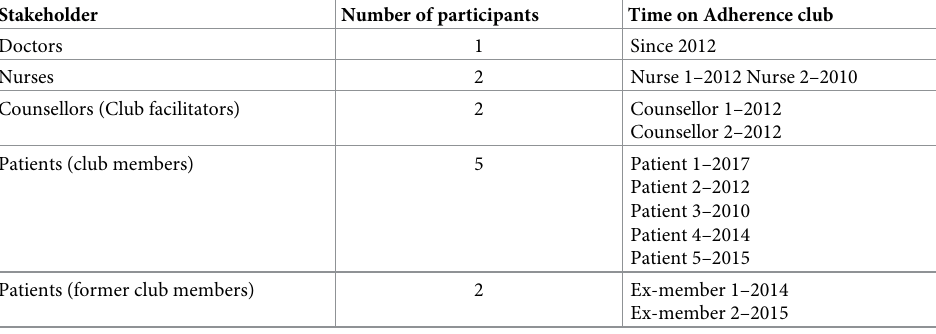
Table 2. Distribution of study